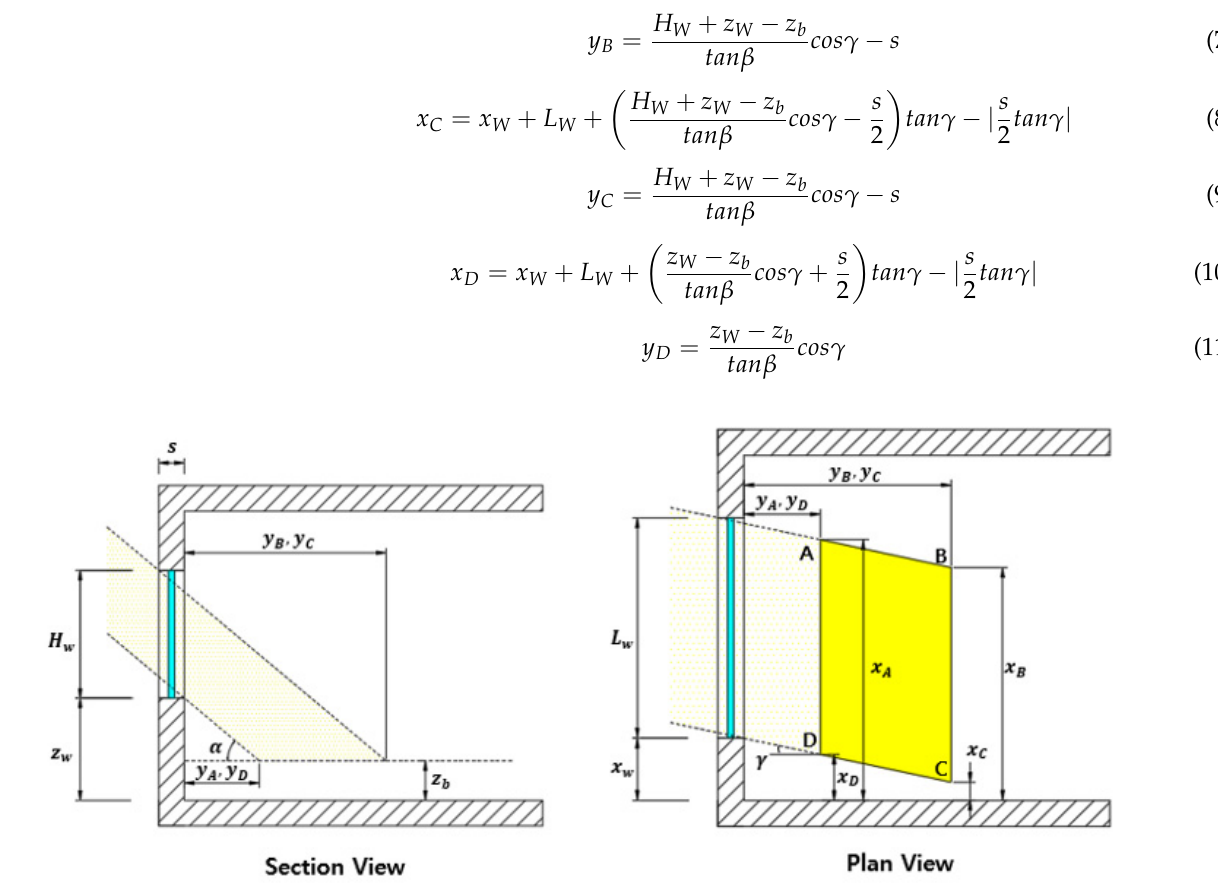
Figure 8. Definition of the geometric parameters involved in the delimitation of the irradiated zone modified with permission from Ref. [33].